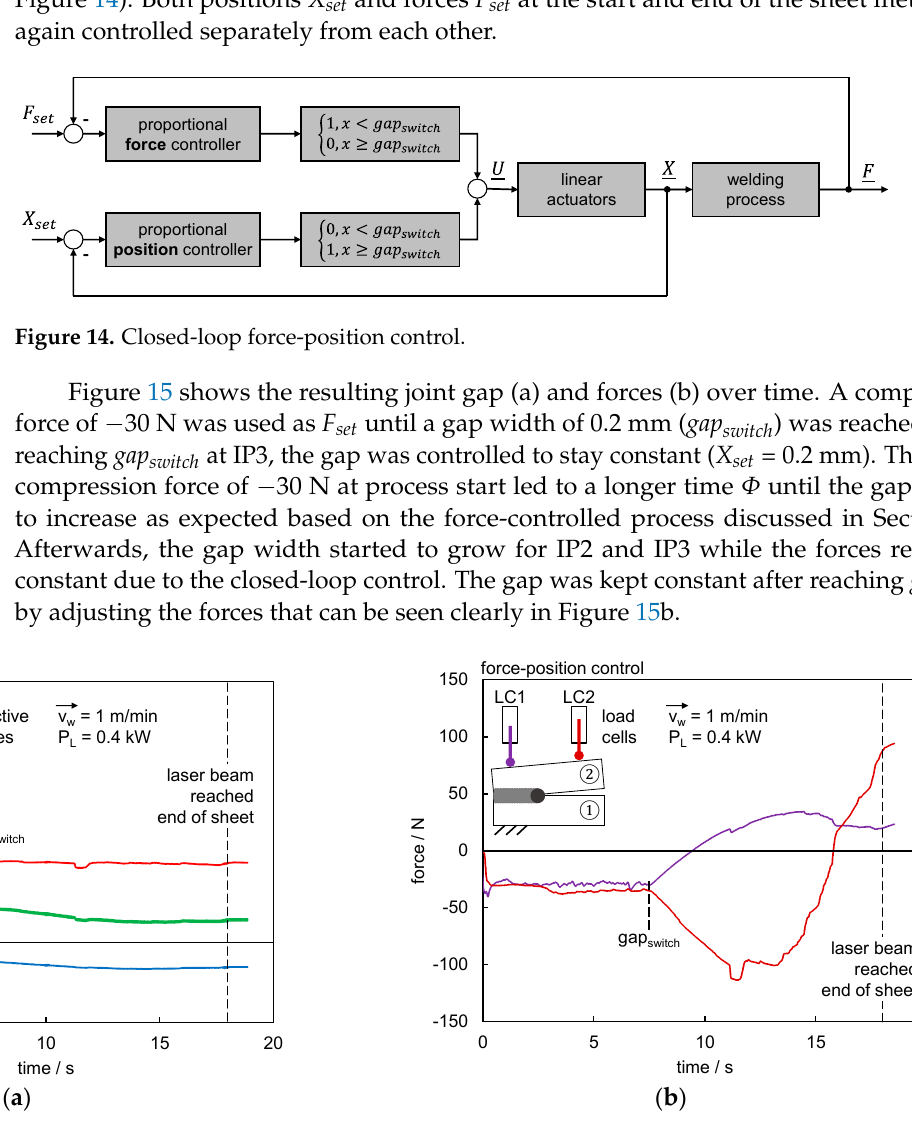
Figure 15. Closed-loop force-position control (v w = 1 m/min, P L = 0.4 kW): ( a ) gap measurement via inductive probes; and ( b ) force measurement via load cells.